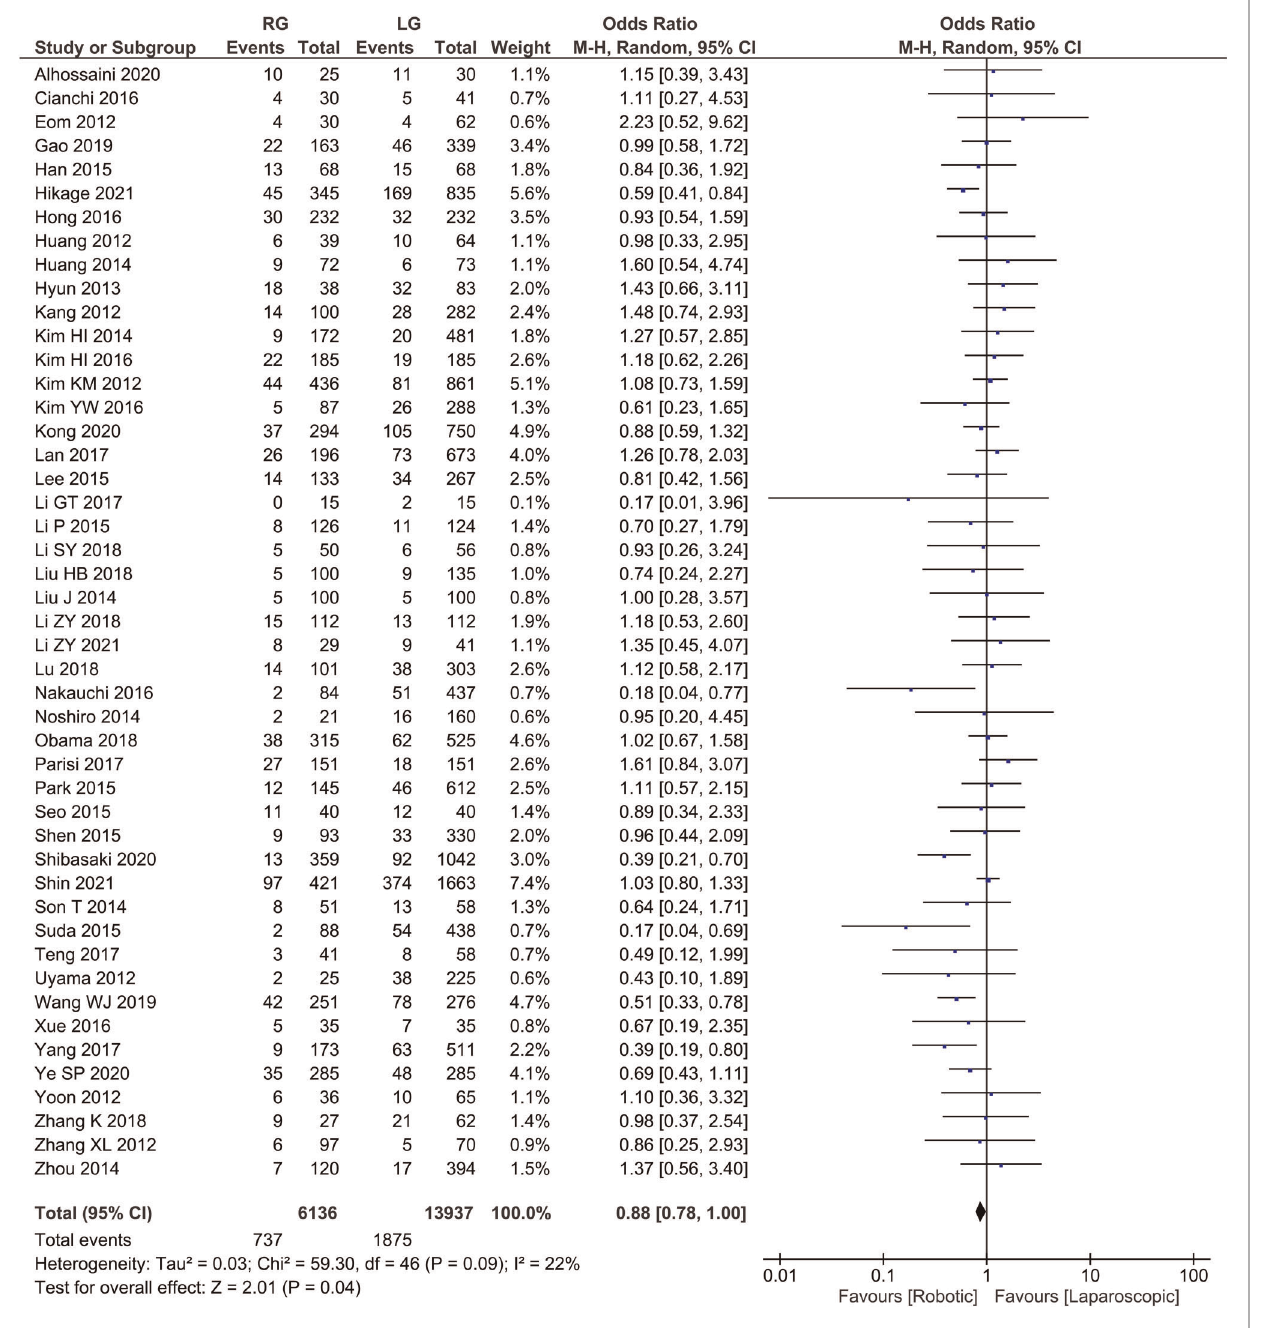
FIGURE 7 | Comparison of postoperative complications between RG and LG